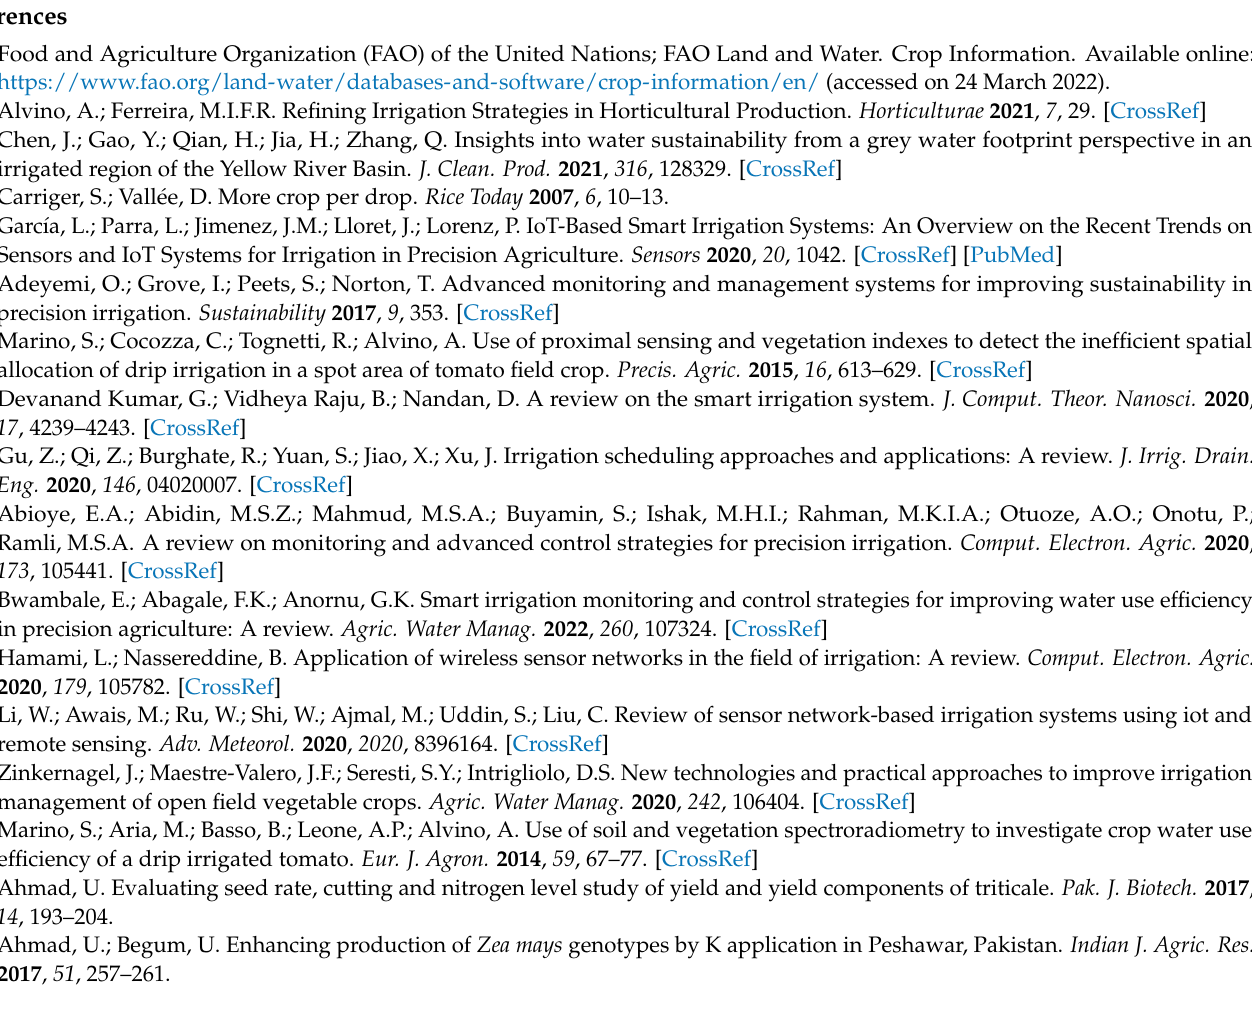
Figure A2. Box plot correlations of environmental parameters at Apulia region over the study period from 1 January 2019 to 31 December 2021. (Note: Tmin, Tmax and Tave = minimum, maximum, and average temperatures ( ◦ C); relative humidity at 9:00 to 21:00 (local time) (%); solar radiation (MJ m 2 month − 1 ); wind speed (m s − 1 ); and rainfall (mm)).